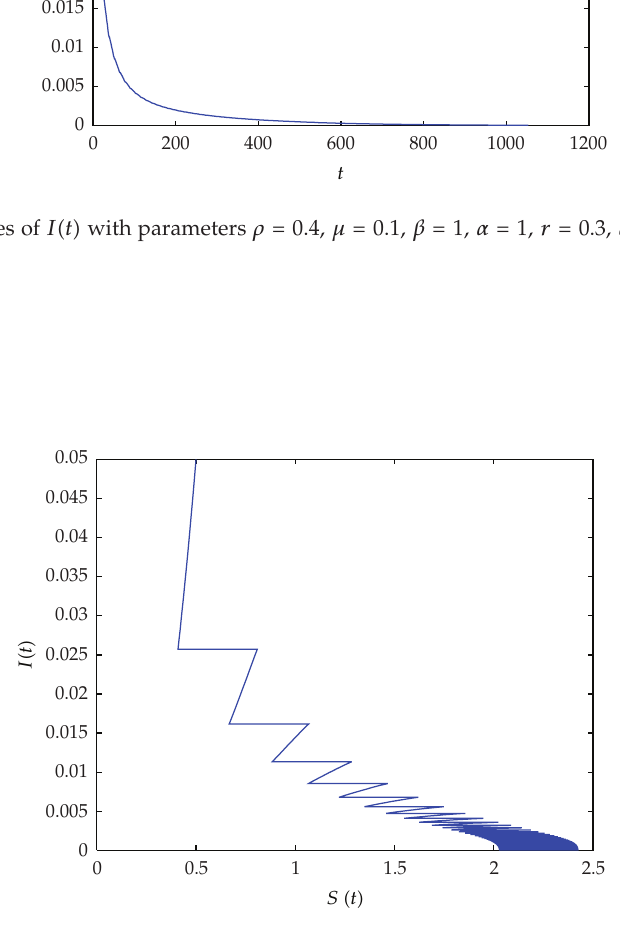
Figure 15: Phase diagram of S (cid:3) t (cid:4) and I (cid:3) t (cid:4) with parameters ρ (cid:7) 0 . 4 , μ (cid:7) 0 . 1 , β (cid:7) 1 , α (cid:7) 1 , r (cid:7) 0 . 3 , d (cid:7) 0 . 2 , ω (cid:7) 0 . 2 , T (cid:7) 0 . 8 , and τ (cid:7) 0 .